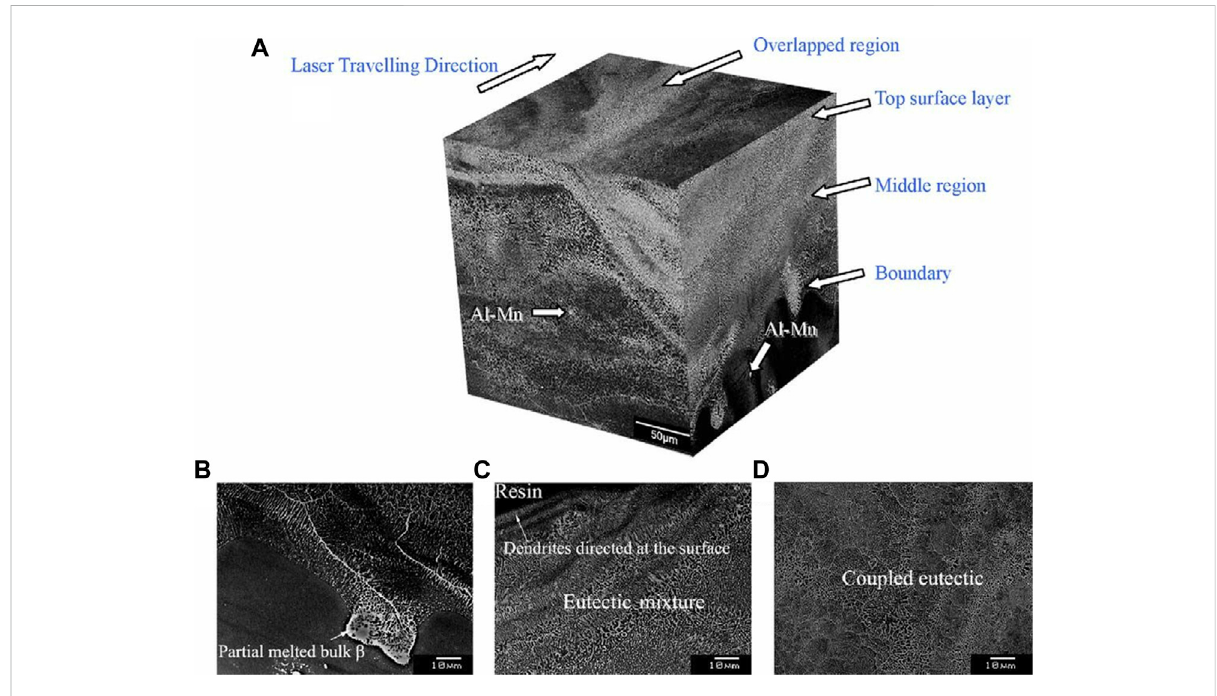
FIGURE 3 Images of typical solidi fi cation microstructure of AZ91D alloy after laser irradiation: (A) three-dimensional image of the laser-melted zone; (B) the boundary between laser-melted region and substrate; (C) the middle region; (D) the top surface. (Guan et al., 2010).